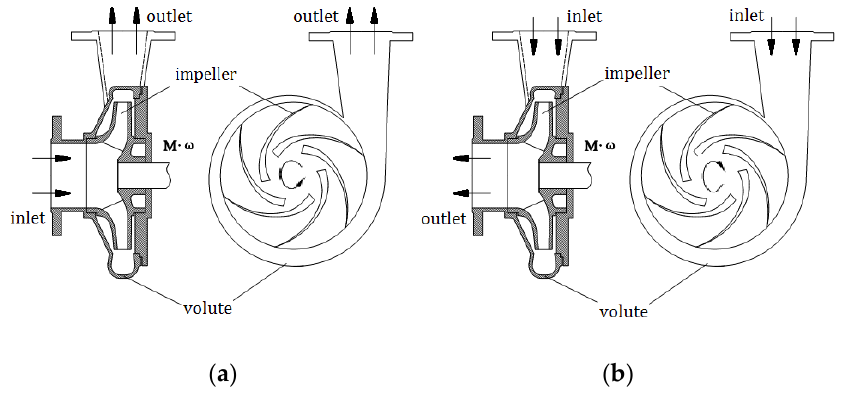
Figure 1. Directions of flow and rotation in pump and pump as turbine (PAT). ( a ) Pump; ( b ) PAT.